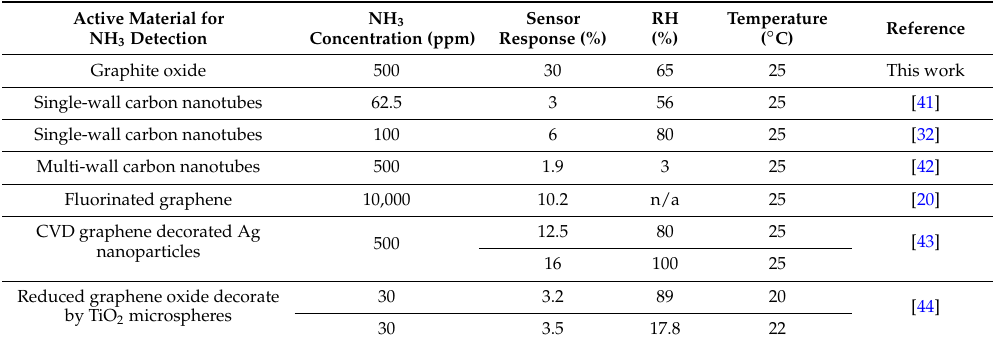
Table 1. GO ammonia sensor performance in a comparison with literature data.